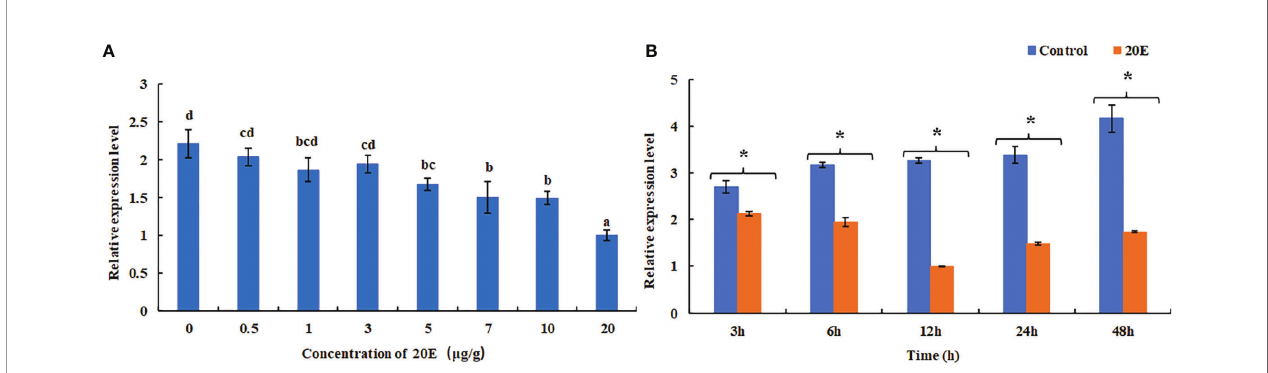
FIGURE 8 | Expression of MnFtz-f1 mRNA under the in fl uence of different concentrations of 20E (A) . Effects of the same concentration of 20E (5 m g/g) on MnFTZ- F1 expression at different time points (B) . Statistical analyses were performed by one-way ANOVA and Student ’ s t -test. Data are expressed as mean ± SEM (n = 6). Bars with different letters and ( * ) indicate signi fi cant differences ( P <